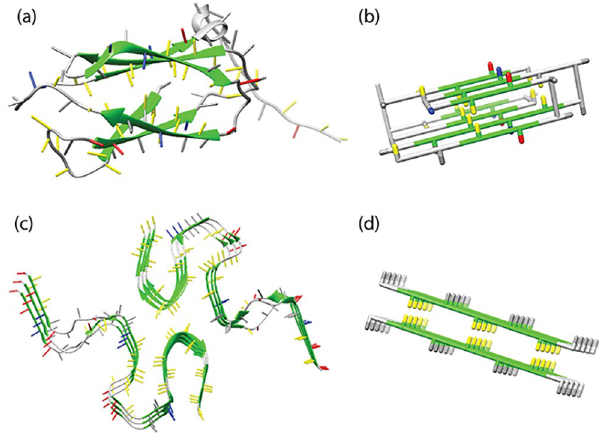
Fig 1. Folded and fibrillar states. (A) The native state of human transglutaminase (PDB-ID: 2XZZ) (B) a model protein in the native state, (C) disease-related amyloid β -sheet of the A β (1-42) peptide (PDB-ID: 2NAO) [28] and (D) the seed structure of an amyloid fibril represented in the lattice model used for this work. Side chains of hydrophobic residues are coloured in yellow, of polar residues in grey, of positively charged residues in blue and of negatively charged residues in red. For β -stranded structures the backbone is coloured in green. In the folded protein, a hydrophobic core can be observed, where the hydrophobic residues are shielded from the water by the hydrophilic and charged residues. Similarly, the core sequence regions of amyloid fibril structures tend to be strongly